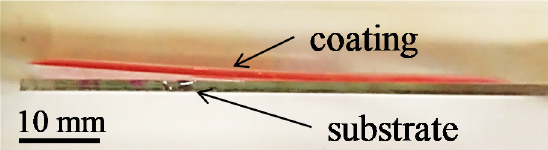
Figure 14. Side-view of a delaminated coating/substrate sample due to a thermal shock of − 100